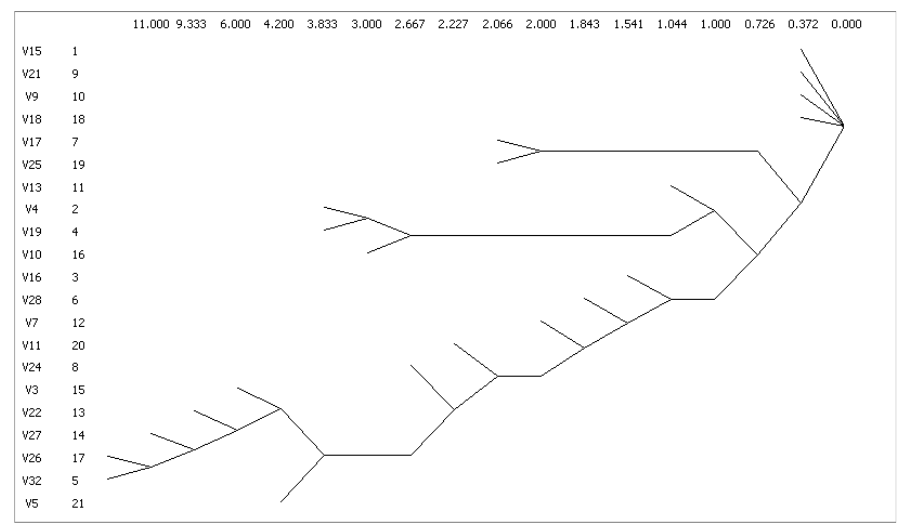
Figure 7. Factional analysis tree of the network.